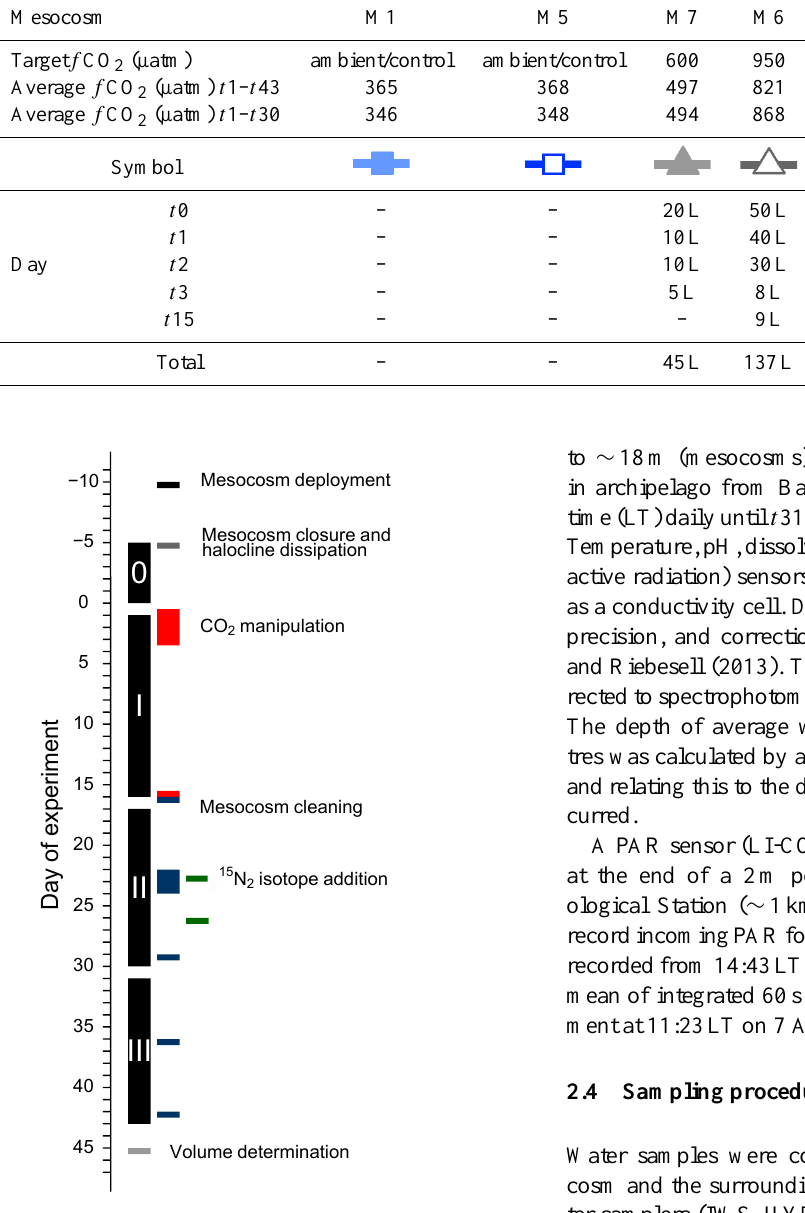
as CO 2 manipulations (red), cleaning (dark blue), phases (black,